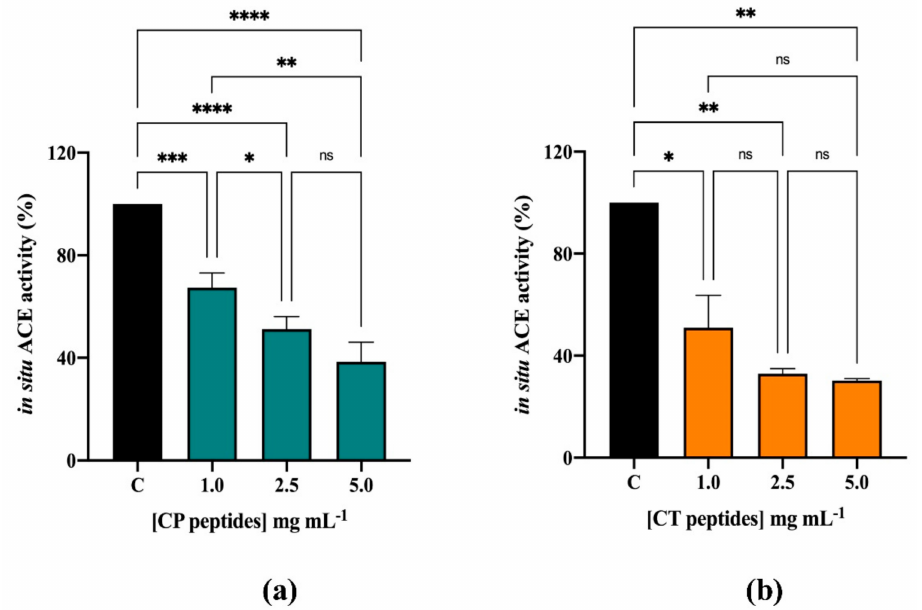
Figure 3. Evaluation of the inhibitory effects of CP ( a ) and CT ( b ) hydrolysates on ACE expressed by Caco-2 cell membranes. Bars represent the SD of 3 independent experiments in duplicate. **** p < 0.0001, *** p < 0.001, ** p < 0.01, * p < 0.05, ns, no significantly different versus Control sample